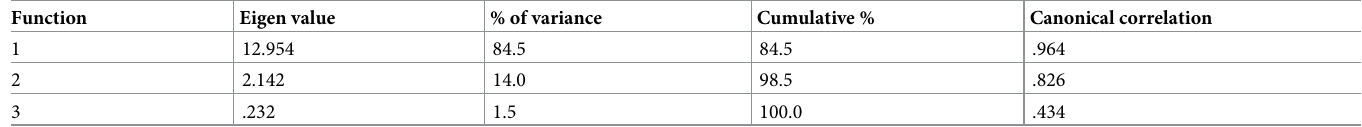
Table 5. Eigenvalue functions, % of variance, Cumulative variance (%), and Canonical Correlations during a CDA. Function